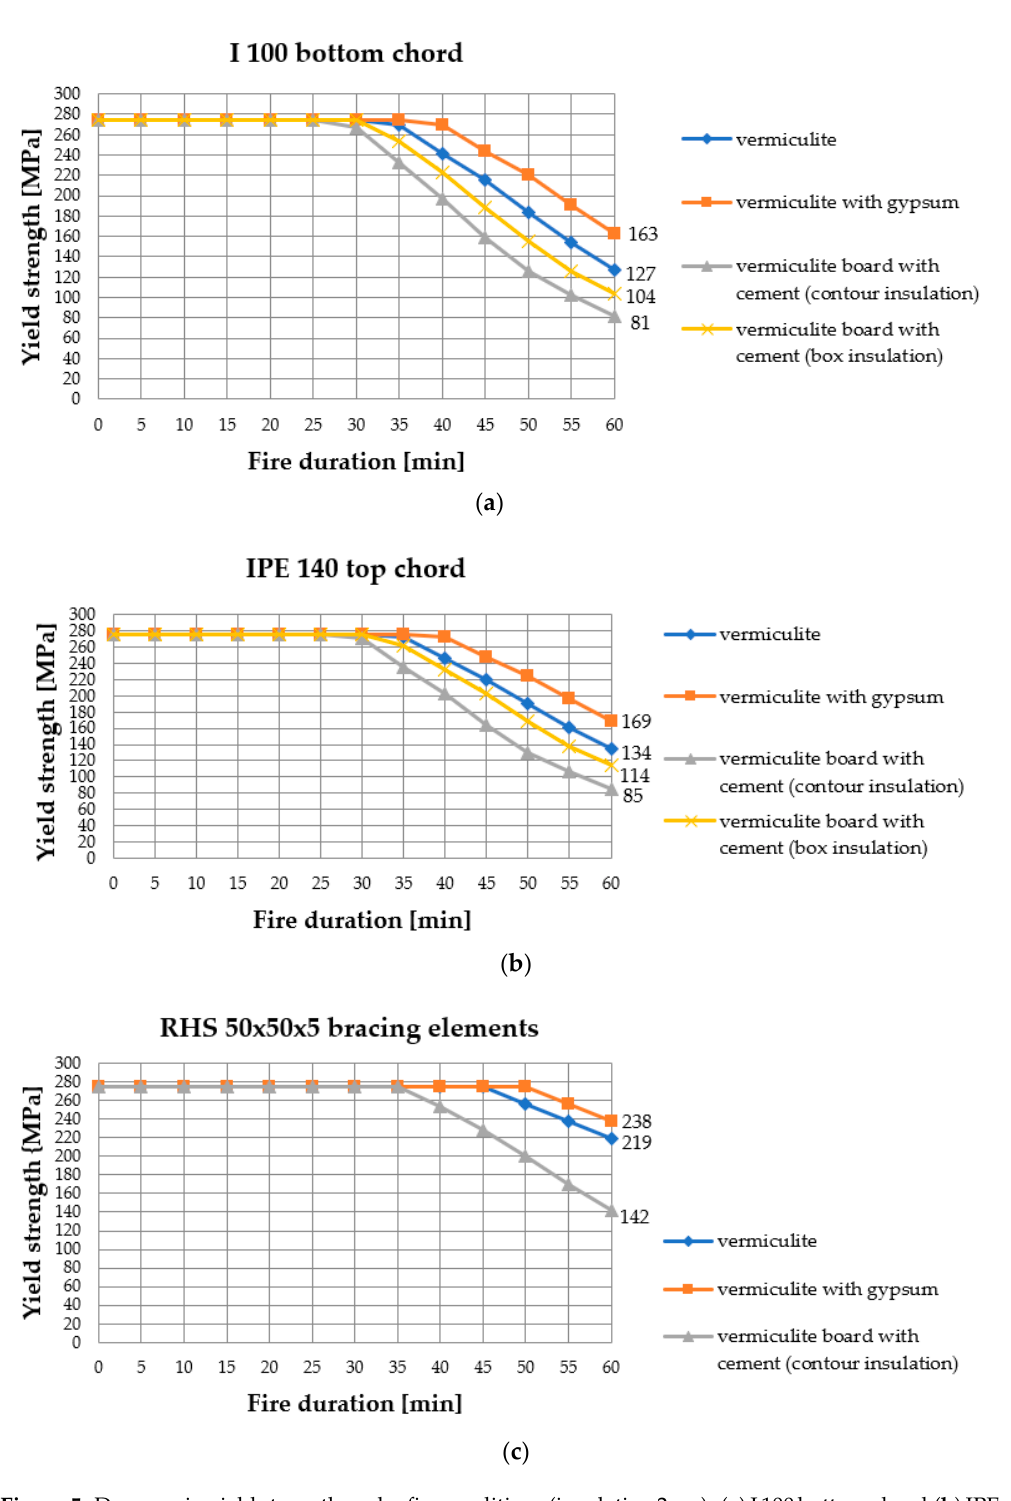
Figure 5. Decrease in yield strength under fire conditions (insulation 2 cm): ( a ) I 100 bottom chord, ( b ) IPE 140 top chord, ( c ) RHS 50x50x5 bracing elements.